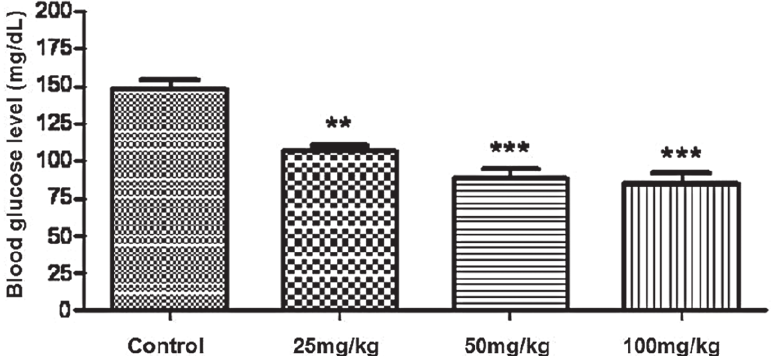
Figure 2 - The effect of administration of stem bark aqueous extract from P. ramiflora (PrSBAE) for eigth days on blood glucose level in mice. Each column represents mean±S.E.M for five mice. * P < 0.05, ** P < 0.01, *** P < 0.001 different from control